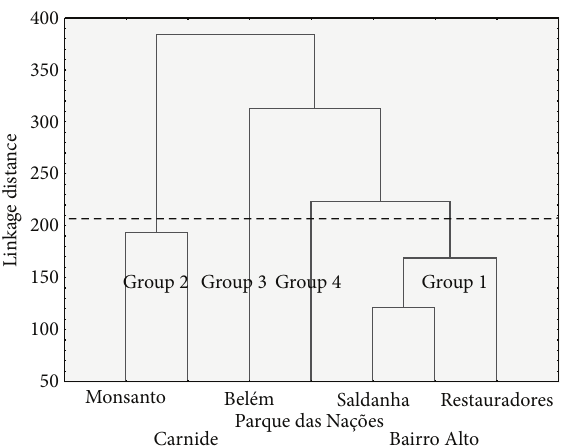
Figure 2: Similarity groups of the thermal deviations of each station of the urban mesoscale network and the Portela Airport. Data: CliMA- CEG and IPMA.